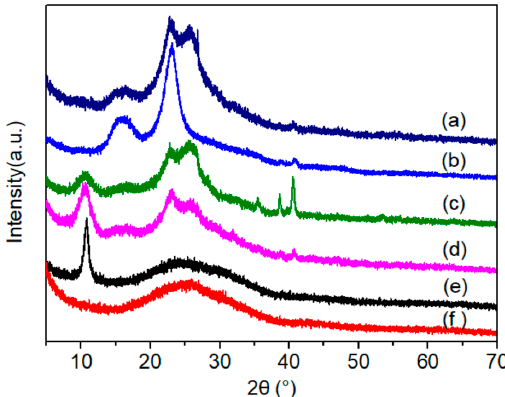
Figure 11. X-ray diffraction (XRD) patterns recorded for ( a ) 5 wt.% GO membrane (50 wt.% graphene); ( b ) NFC membrane; ( c ) 50 wt.% graphene membrane (GO:NFC = 1:1); ( d ) 30 wt.% graphene membrane (GO:NFC = 1:1); ( e ) GO membrane; and ( f ) graphene sheet.